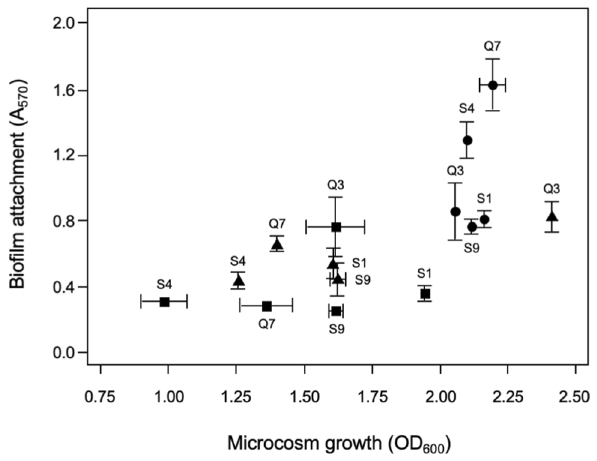
Figure 4. Combined biofilm assay after 3 days incubation. KB, circle, LB square, BHI, triangle. Biofilm attachment/growth in different media. Means ± SE are shown; significant differences between biofilm attachment levels (A 570 ) and microcosm growth (OD 600 ) were found between strains (ANOVA, p < 0.05) but for the sake of clarity these are not shown in this figure.